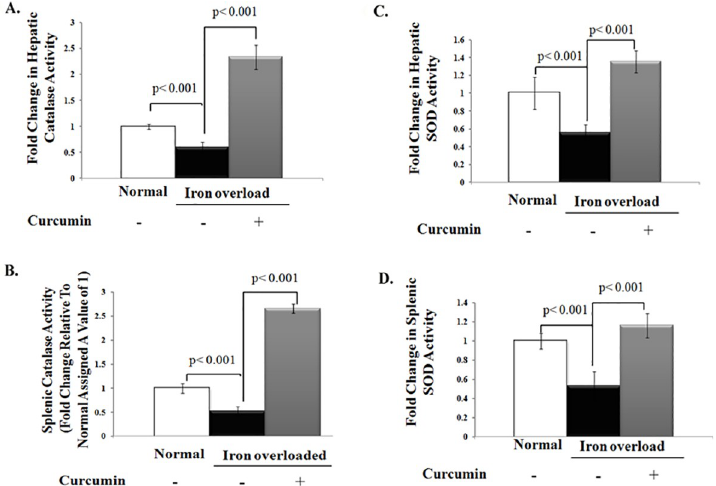
Fig 4. Curcumin boosts activities of endogenous enzymatic antioxidants that were depleted with chronic iron overload. A, B) Fold change in catalase (CAT) activity (U/g tissue) in liver and spleen relative to that of normal control, which was assigned a value of 1; C, D) Fold change in Superoxide dismutase (SOD) activity (U/g tissue) in liver and spleen relative to that of normal control which was assigned a value of 1. Activities of CAT and SOD in these tissues were significantly decreased in iron overloaded rats than controls. Curcumin treatment significantly boosted activities of both CAT and SOD in iron overloaded rats even to higher levels than those of control rats. Data shown are the mean ± SD (n =